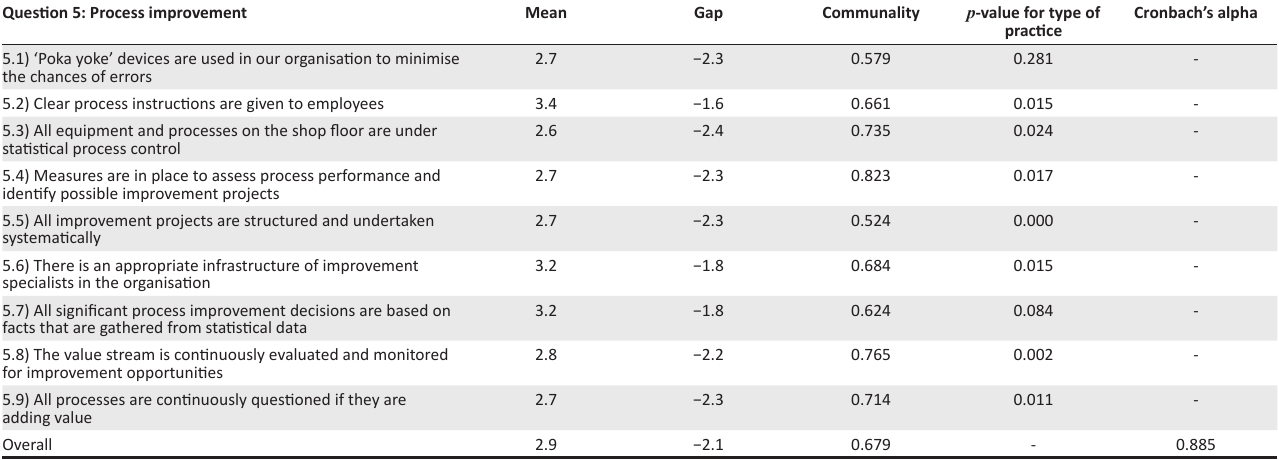
TABLE 6: Results pertaining to process improvement. Question 5: Process